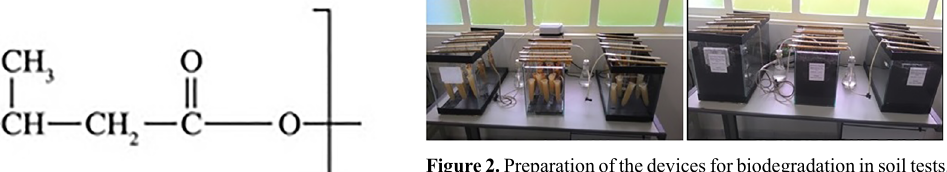
Figure 2. Preparation of the devices for biodegradation in soil tests.